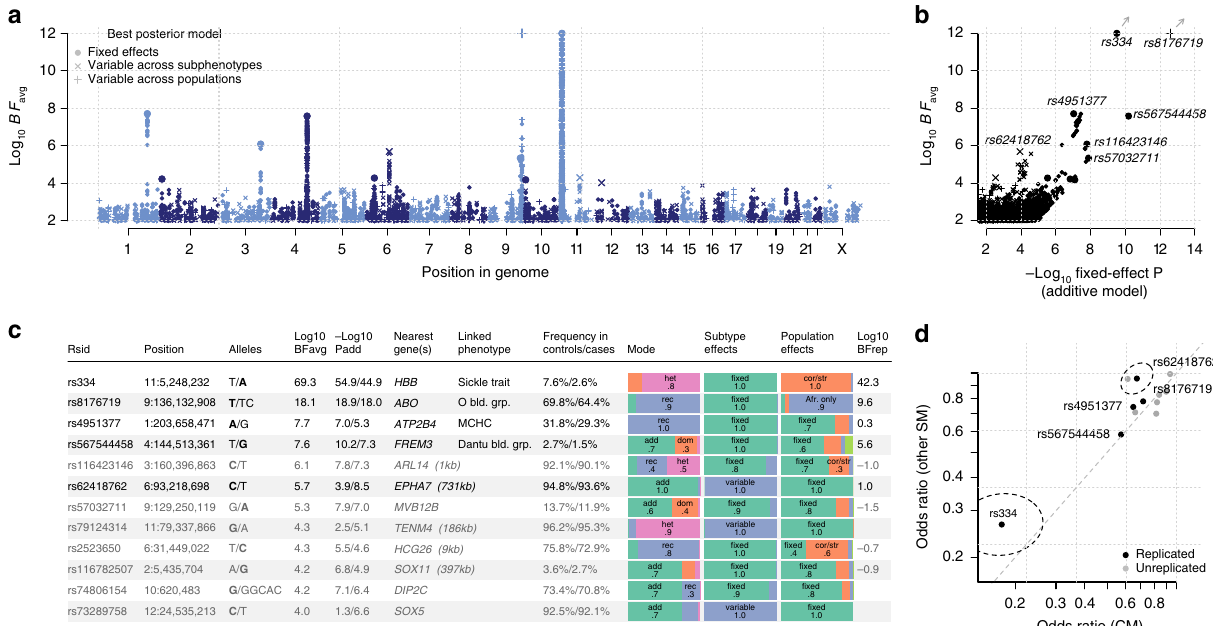
Fig. 2 Evidence for association with severe malaria. a Association evidence (log10 BF avg , y axis; clamped to a maximum of 12) at typed and imputed SNPs and indels genome-wide (x axis). BF avg re fl ects evidence under a range of models summarized using prior weights speci fi ed in Methods. Shapes denote whether the model with the highest posterior weight is for effects fi xed across populations and subphenotypes (case – control effect, circles), or suggests variation in effect between populations (crosses) or between subphenotypes (plusses). b Comparison of model-averaged Bayes factor (log10 BF avg , y axis) and the evidence under an additive model of association with overall SM ( − log10 P add , x axis). For visualization purposes, we have removed variants in the region of rs334 (HbS, chromosome 11) and rs567544458 (glycophorin region, chromosome 4) except the lead variant. Shapes are as in a . The values for rs334 and rs8176719 lie outside the plot as indicated by arrows; to visualize these we have projected them onto the plot boundary. c Twelve regions of the genome with BF avg > 10,000. Columns re fl ect the ID, genomic position, reference, and alternative allele with estimated protective allele indicated in bold, log10 BF avg , − log10 P -value for an additive model of association with SM or with SM subtypes, nearest gene and distance to the nearest gene for intergenic variants, known linked phenotypes and combined protective allele frequency across African control and case samples. Bar plots summarize our inference about the mode of effect of the protective allele and the distribution of effects between SM subtypes and between populations. The last column re fl ects the evidence for association observed in replication samples (log10 BF replication ), assessed using the effect-size distribution learnt from discovery samples, based on direct typing of tag SNPs as detailed in Supplementary Data 1. Rows are in bold if they showed positive replication evidence (BF replication > 1). d Comparison of estimated effect sizes for the protective allele on CM (y axis) and on unspeci fi ed SM cases (x axis) for the 12 variants in c . The 95% con fi dence region for rs334 and rs62418762 (dashed ellipses) are shown. Source data are provided as a Source Data fi